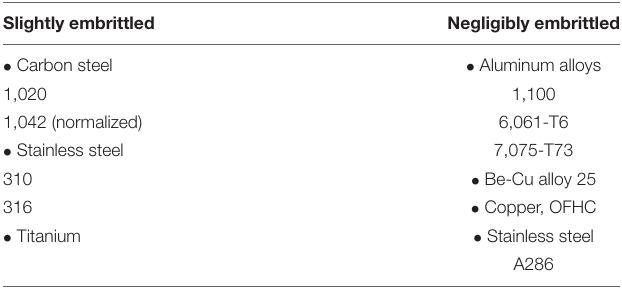
TABLE 7 | Hydrogen embrittlement susceptibility of commonly used metals/alloys (ISO, 2004). Slightly